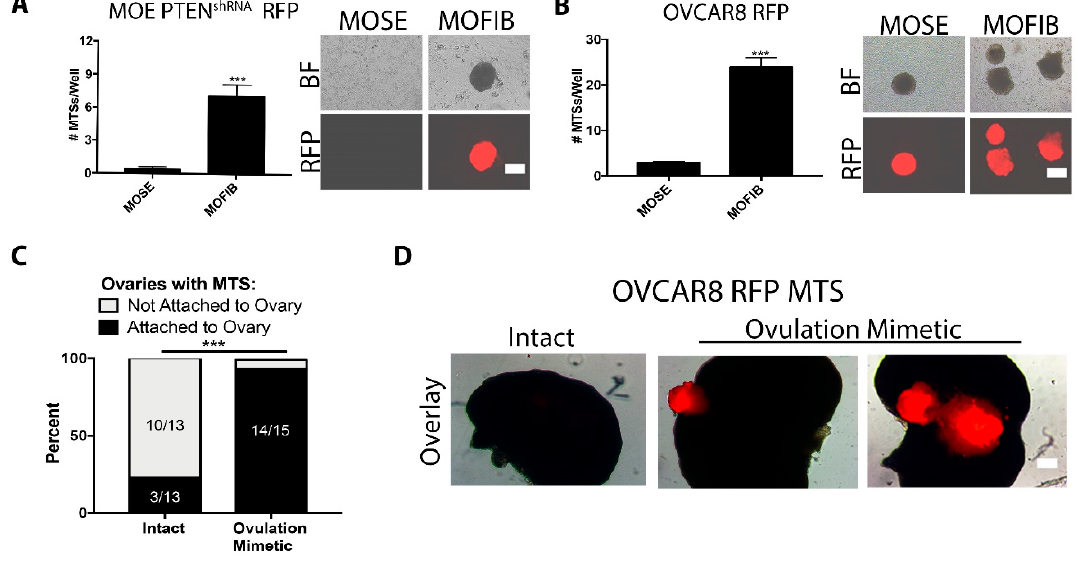
Figure 5. MTS attach to ovarian stroma exposed during ovulation. ( A , B ) Number of MOE PTEN shRNA RFP ( a ) and OVCAR8 RFP ( B ) MTS attached to confluent monolayers of murine ovarian surface epithelia (MOSE) and murine ovarian fibroblasts (MOFIB) cells after 24 h with representative images. Data are presented as mean ± SEM and were analyzed by Student’s t -test. *** p < 0.001 relative to MOSE. n = 4. Scale bar = 10 μ m. ( C ) Attachment of OVCAR8 RFP MTS to intact and ovulation mimetic ovaries. Analyzed by Fisher’s exact test. *** p < 0.001 relative to intact. n = 13–15. ( D ) Representative images of OVCAR8 RFP MTS attached to ovulation mimetic ovaries. Legend: BF, brightfield. Scale bar = 10 μ m.